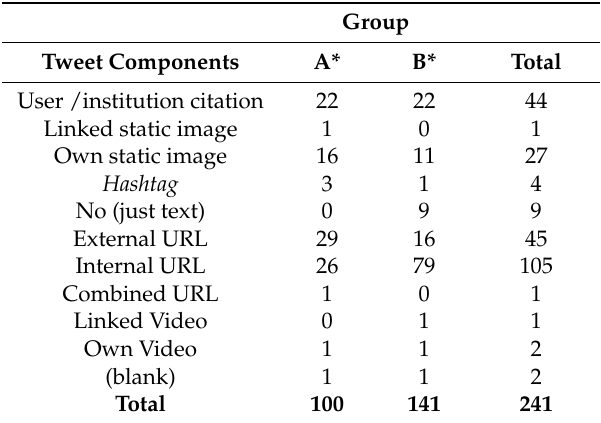
Table 4. Tweet components in both RT